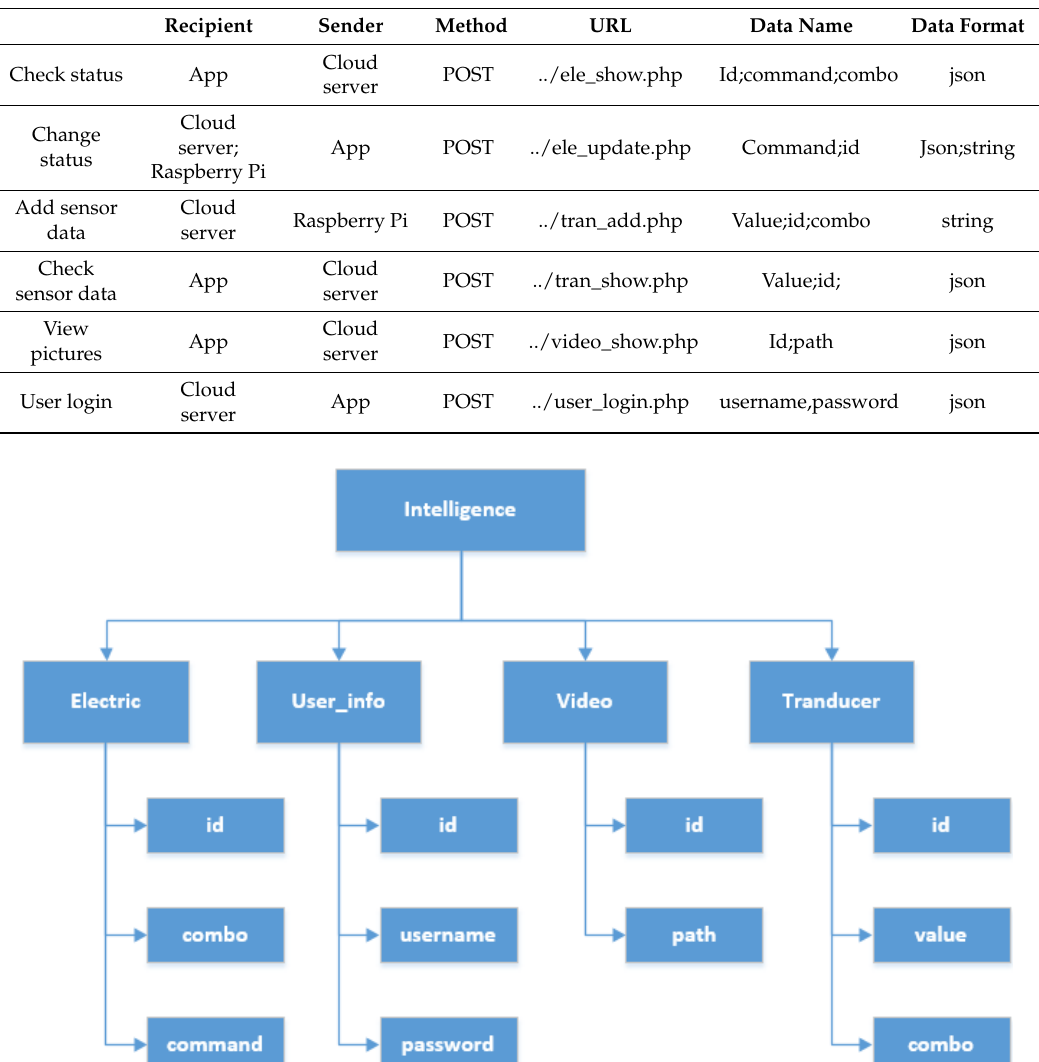
Table 3. Features of cloud server program and mobile synchronization.